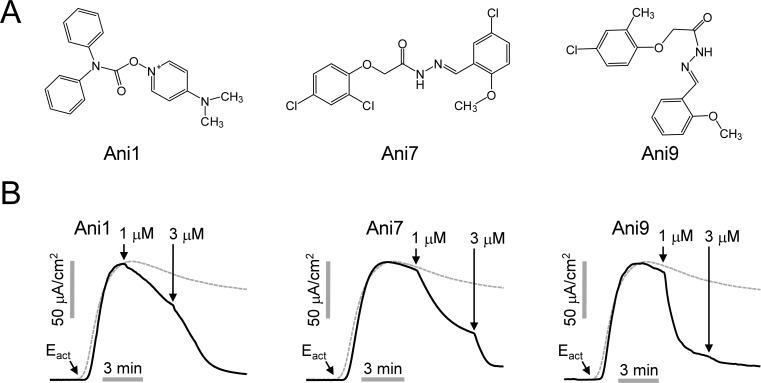
Identification of novel inhibitors of ANO1.A) Chemical structures of ANO1 inhibitors. B) Apical membrane current measured in ANO1 expressing FRT cells in the presence of a transepithelial chloride gradient. Representative current traces showing Ani1, Ani7 and Ani9-induced ANO1 inhibition at the indicated concentrations. ANO1 was activated by 10 μM Eact, a specific activator of ANO1. The dashed gray line shows a control trace.